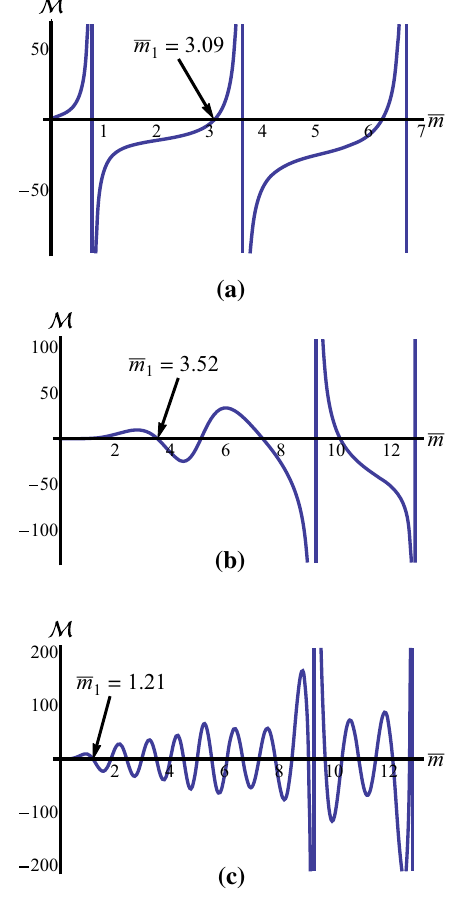
Fig. 9 The effect of the Yukawa coupling constant η and the size of the extra dimension ¯ z b on the mass spectrum of the left-chiral fermion KK modes. The parameter k is set to k = −